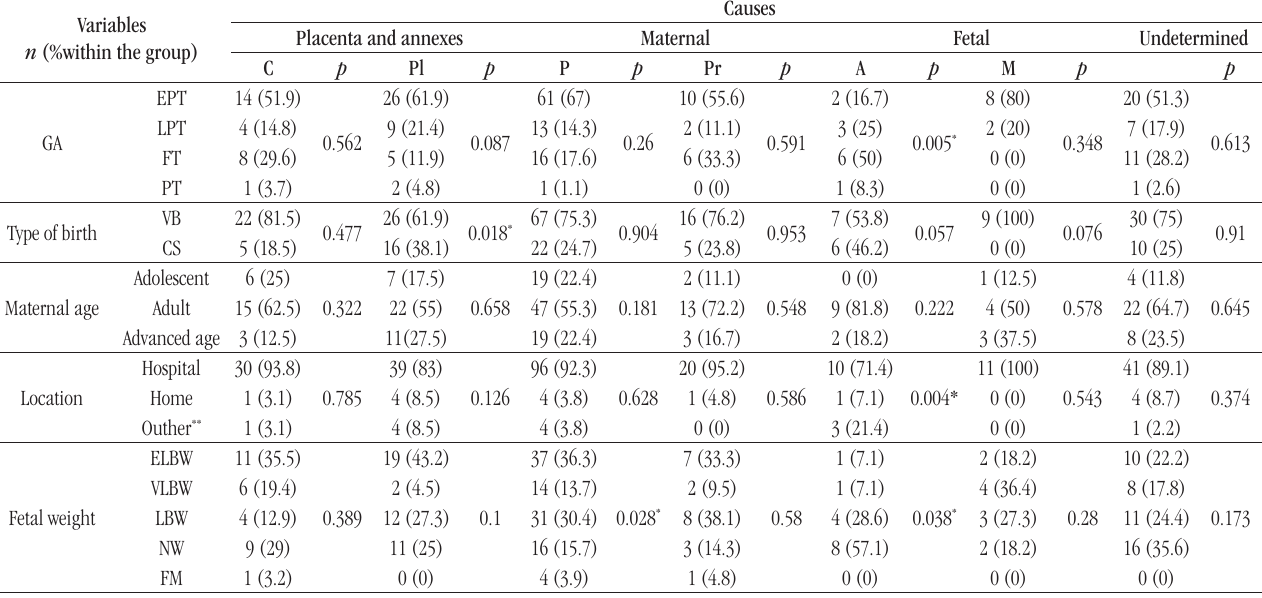
taBLE 3 − Comparison of fetal death causes with clinical and sociodemographic